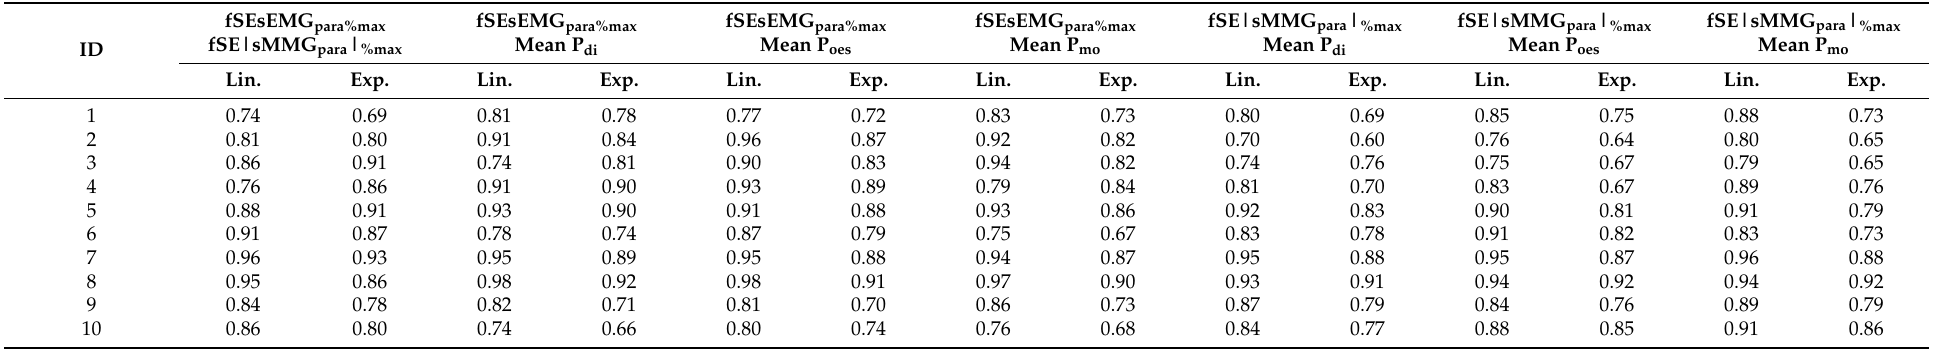
Table 2. Adjusted R 2 of the linear and exponential regression models to describe the relationships between measurements of respiratory pressures, fSE|sMMG para | %max , and fSEsEMG para%max